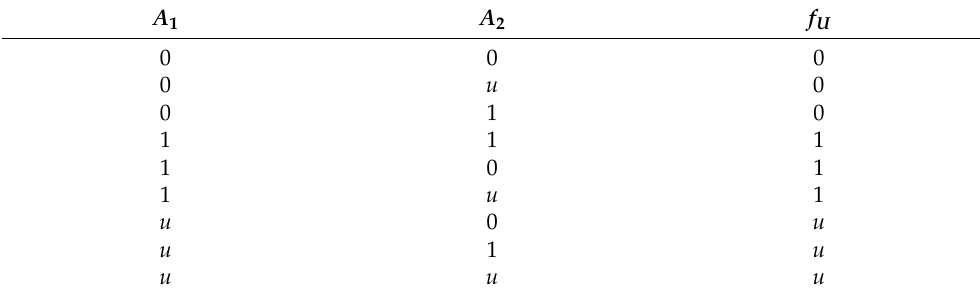
Table 9. Kleene extension coding for two variables.